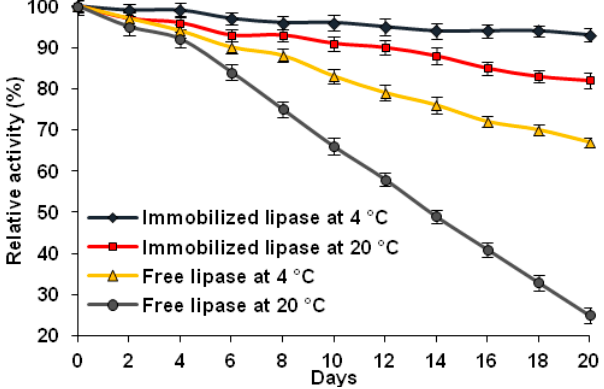
Figure 11. Storage stability of the free and immobilized lipase stored at 4 °C and 20 °C.